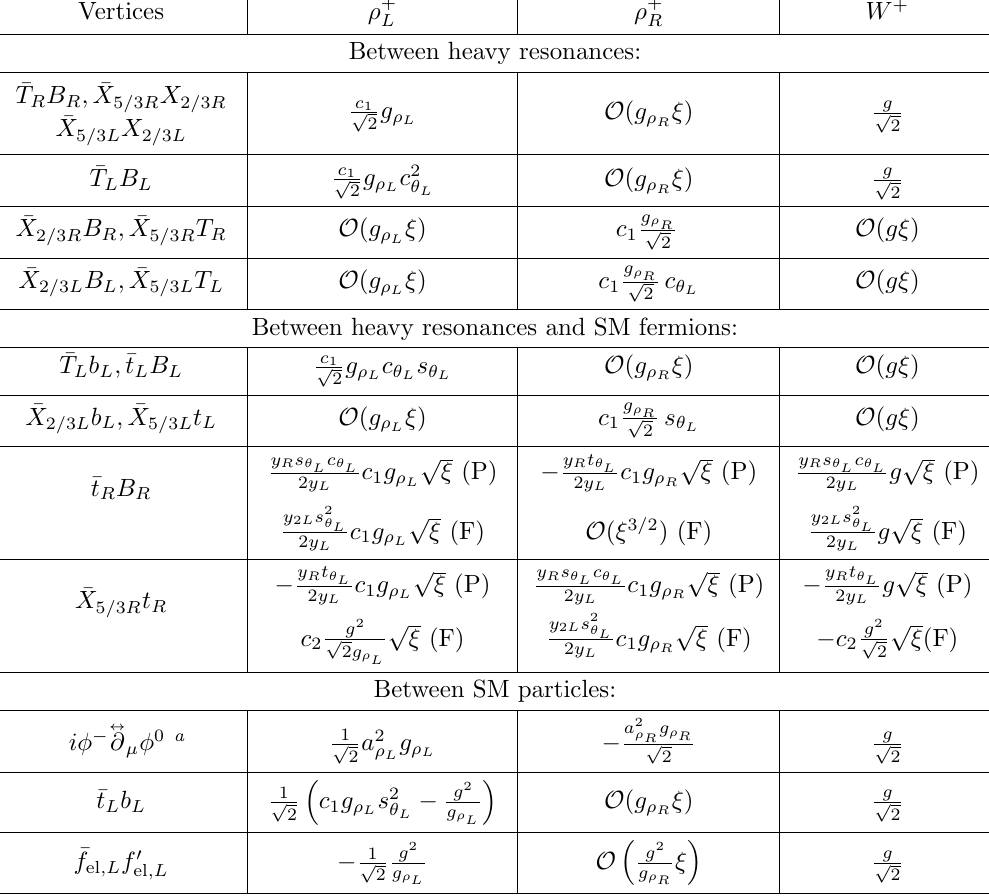
, W (cid:6) and the fermions L;R